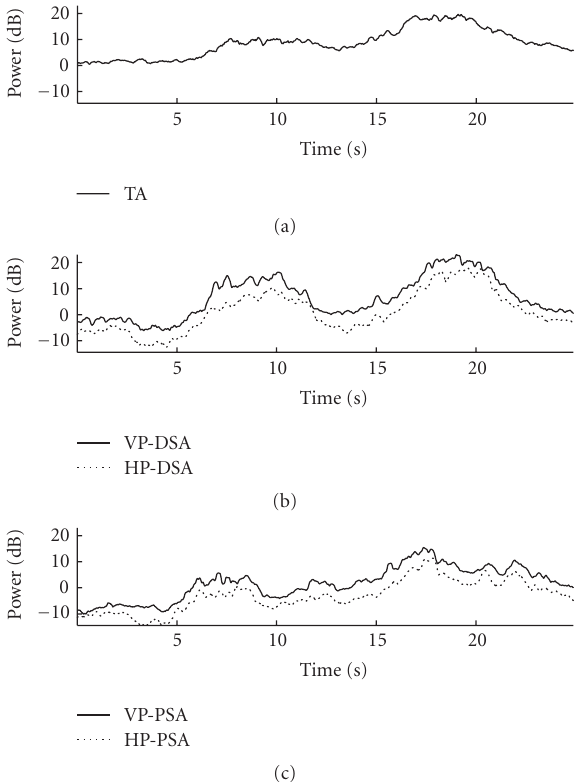
at the DSA is higher than that measured at the TA due to the directional gain pattern of the patch